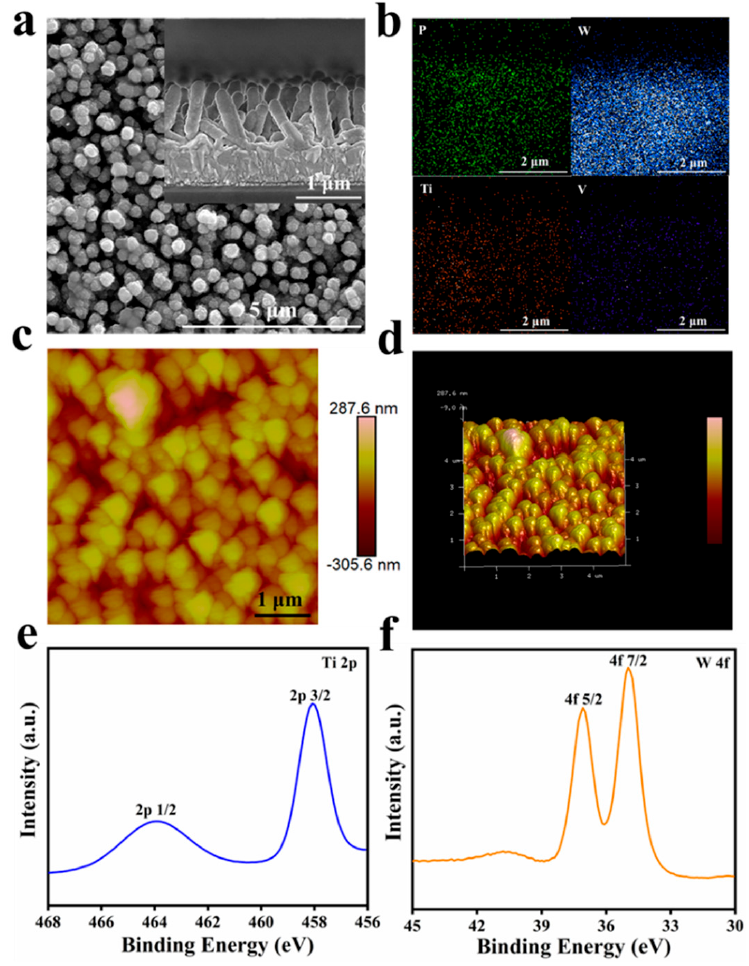
Figure 2. ( a ) SEM images of NW − P 2 W 17 V (inset: the cross-sectional images of prepared films); ( b ) EDS mapping of NW − P 2 W 17 V for P, W, Ti and V respectively; ( c ) 2D AFM images; and ( d ) 3D AFM images of NW − P 2 W 17 V films; High-resolution XPS spectra for Ti 2p ( e ) and W 4f ( f ).